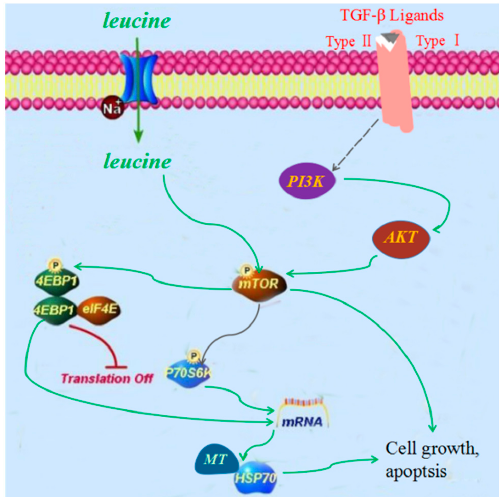
Figure 7. Molecular and protein network function. The solid arrows: Direct Stimulatory Modification; the dotted arrow: Tentative Stimulatory Modification; TGF- β : transforming growth factor- β ; AKT: protein kinase B; MT: metallothionein; HSP70: heatshockprotein70; P: